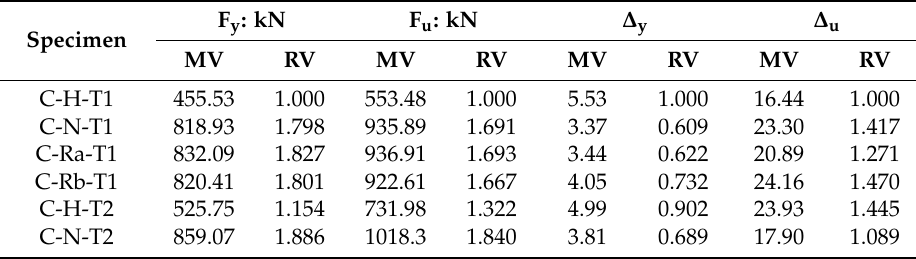
Table 6. Experimental results of yield load, and peak load and their corresponding axial deformation. F y : kN F u : kN ∆ y ∆ Specimen